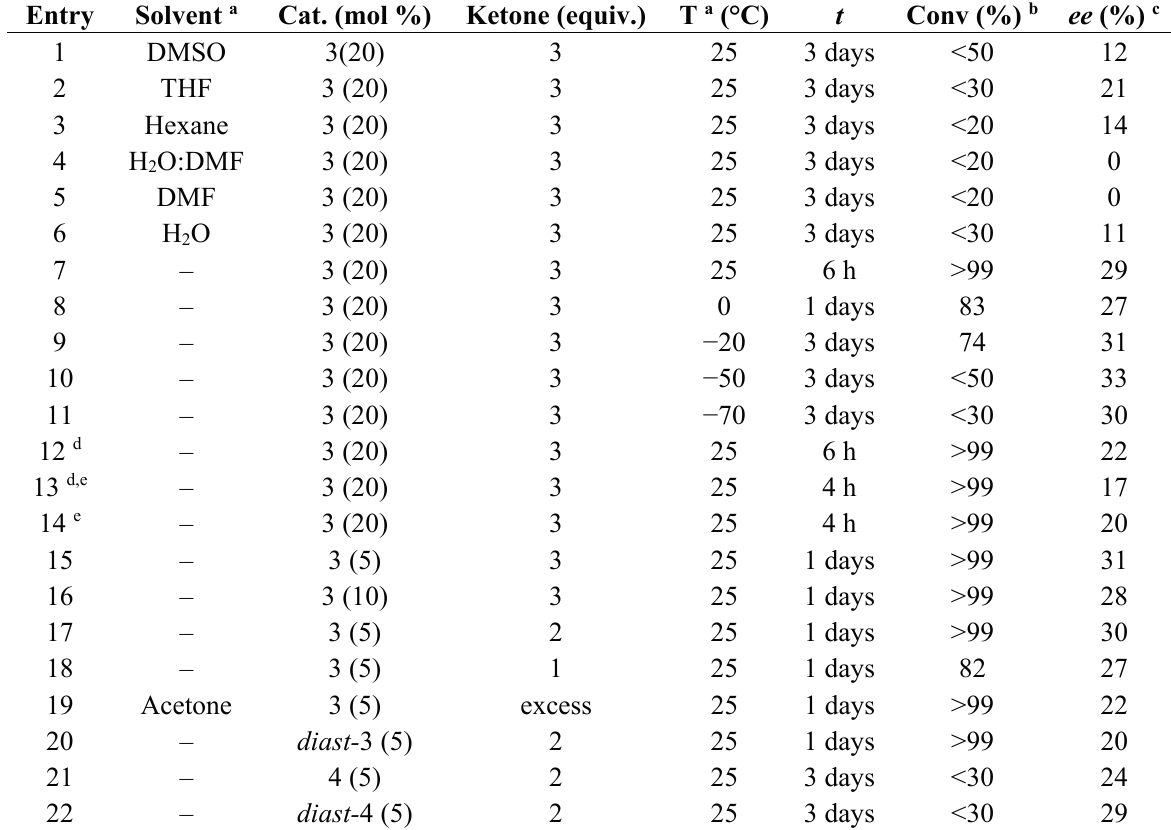
Table 1. Optimization of reaction